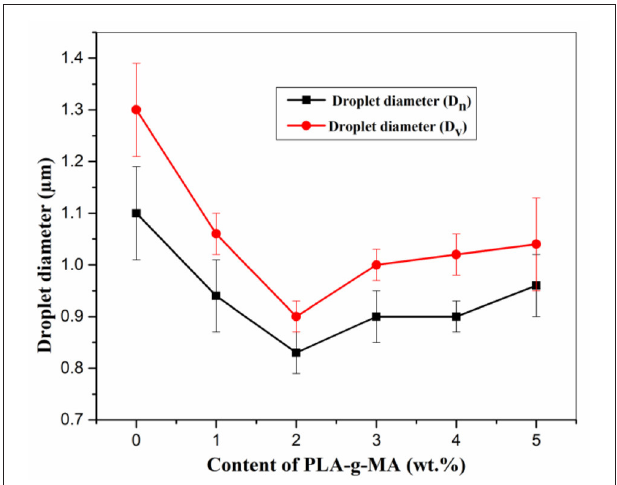
FIGURE 7 | Droplet diameter of PLA/PA12 blends with varying concentration of PLA-g-MA.